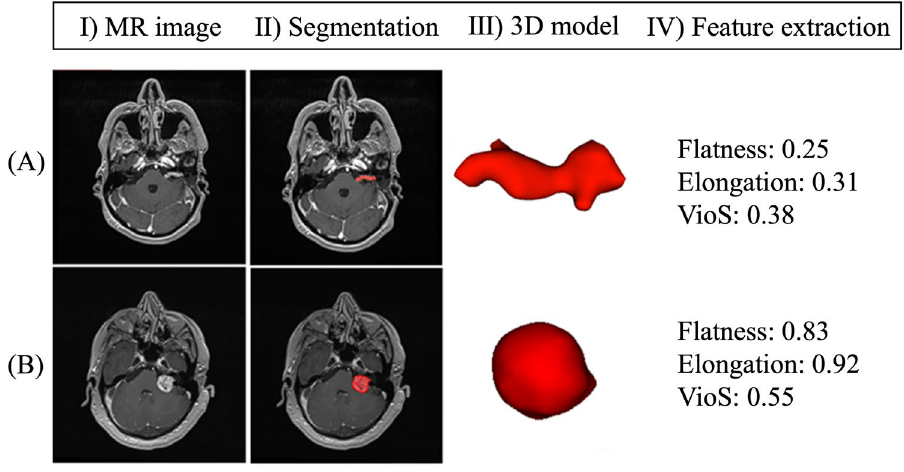
Figure 1. Workflow of the shape feature extraction. ( Ι ) MRI images of two representative vestibular schwannomas. ( II ) The tumor ROIs (red) were defined by an experienced neurosurgeon. ( III ) 3D tumor models constructed using tumor outlining. ( IV ) Three different shape features for tumor A and B. The differences in shape irregularity in the two tumors can be identified by investigating their flatness, elongation, and VioS. Tumor A was flat and irregular, tumor B was more